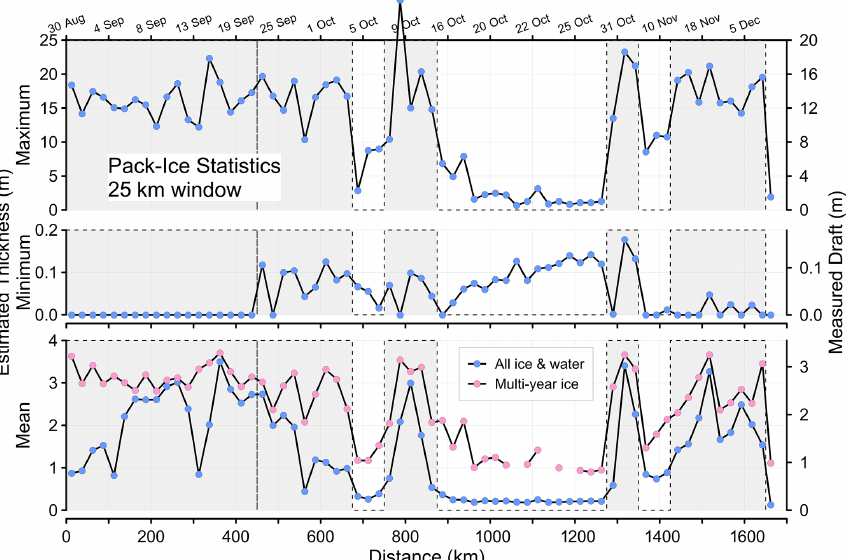
Figure 8. Statistical measures of ice draft for each 25km segment of the drift path. The curve labelled “multi-year ice” represents the mean for ice with draft over 0.75m. Axes on the right indicate draft and those on the left estimated thickness; conversion factors of 1.13 have been used for the mean and minimum drafts and 1.2 for the maximum, as discussed in the text. Dates of measurement are indicated on the top frame. Shading denotes intervals with appreciable multi-year